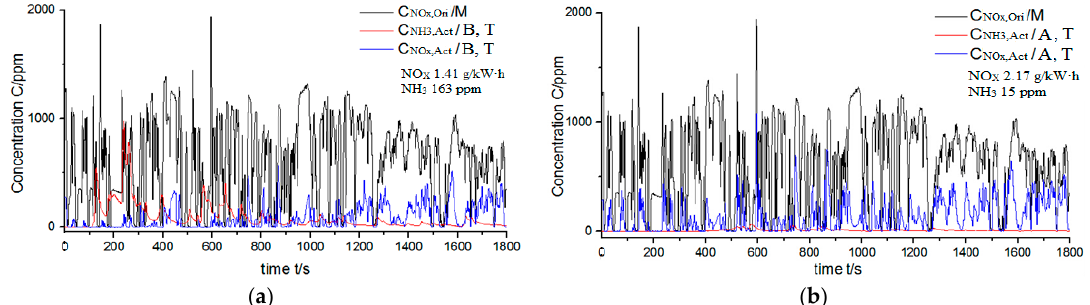
Figure 13. Emissions in the engine ETC cycle. ( a ) Before UWS injection dynamic correction; and ( b ) after UWS injection dynamic correction.